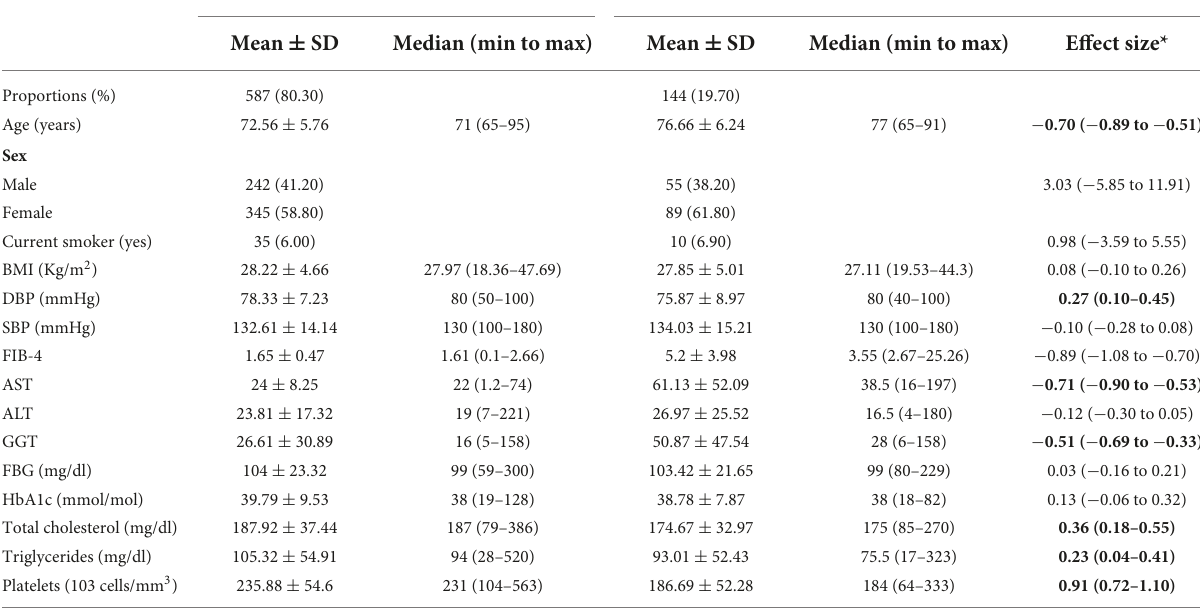
TABLE 2 Description of the whole sample according to the FIB cut-offs.